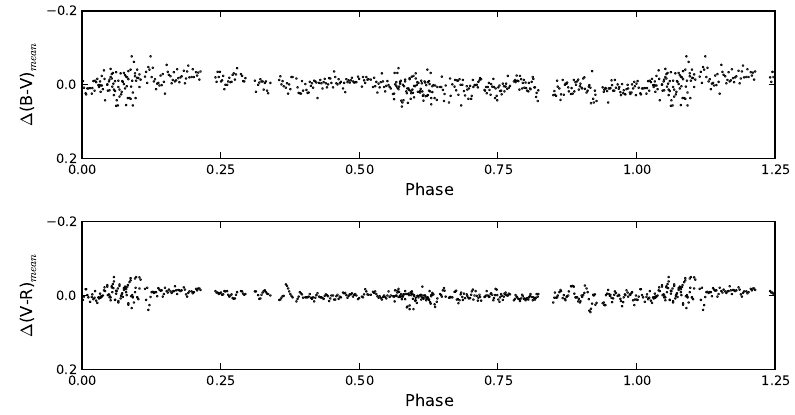
Fig. 1. Color curves B – V and V – R of V407 Peg. The mean color values have been subtracted to better illustrate the variation.